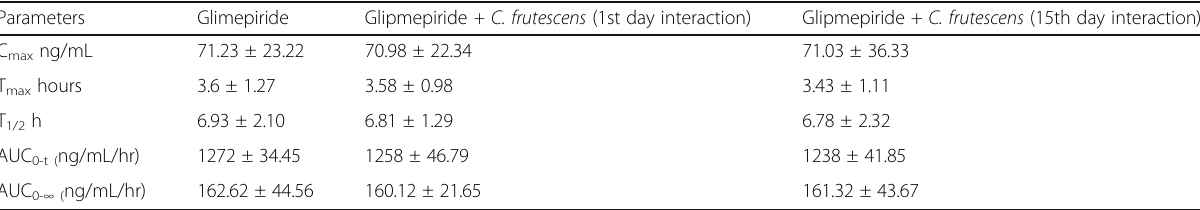
Table. 6 Various pharmacokinetic parameters